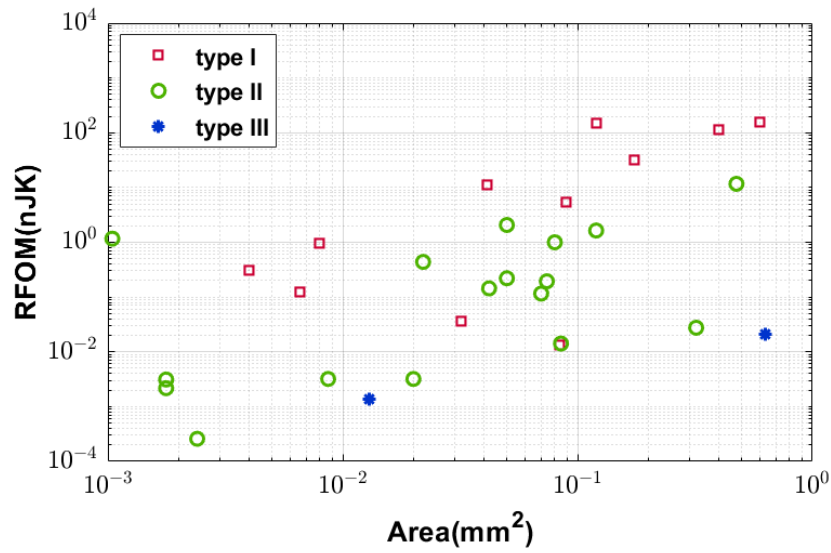
Figure 11. Resolution figure of merit (RFOM, log scale) versus area (log scale), for all three types of MOS-based temperature sensors.